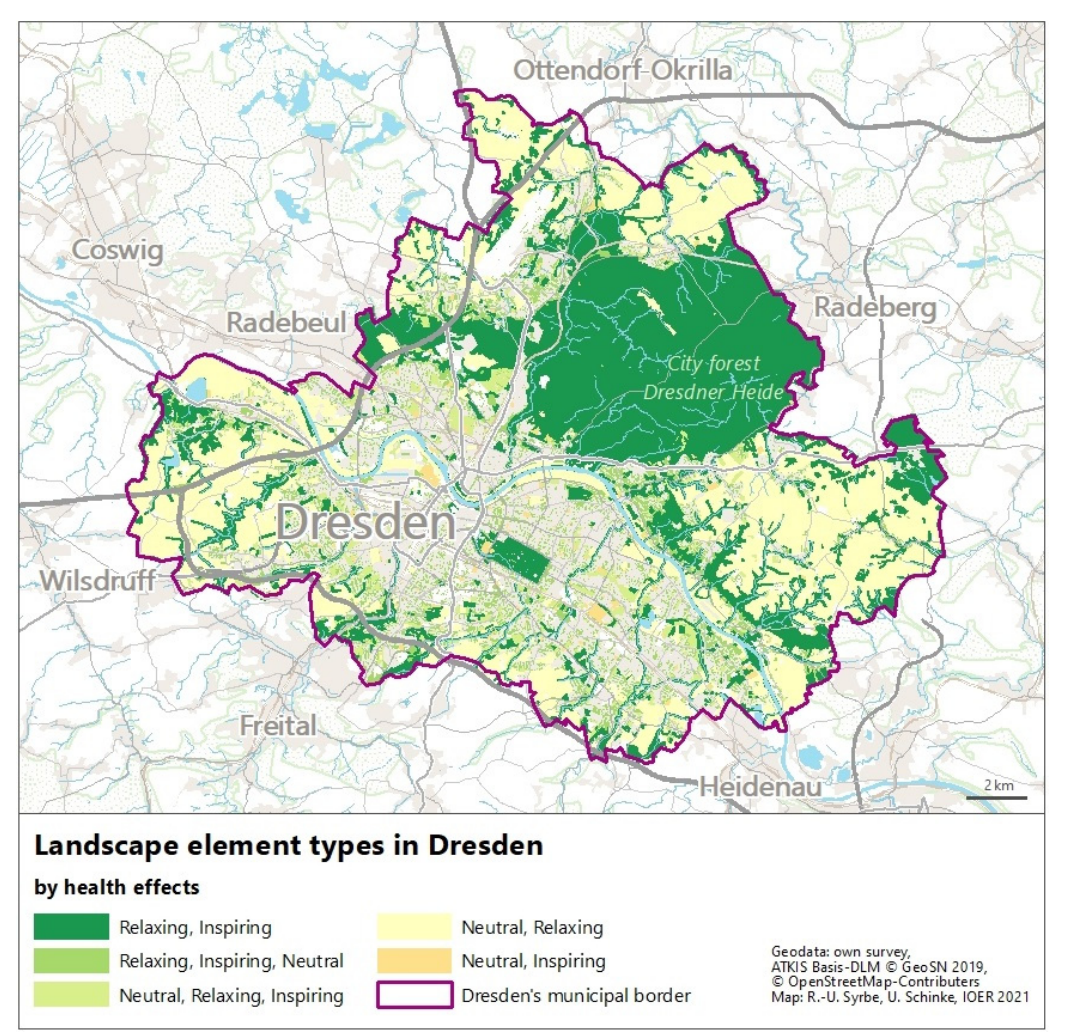
Figure 10. Landscape elements mapped by their health effects as a potential resource for recreation in Dresden (source: authors’ elaboration).